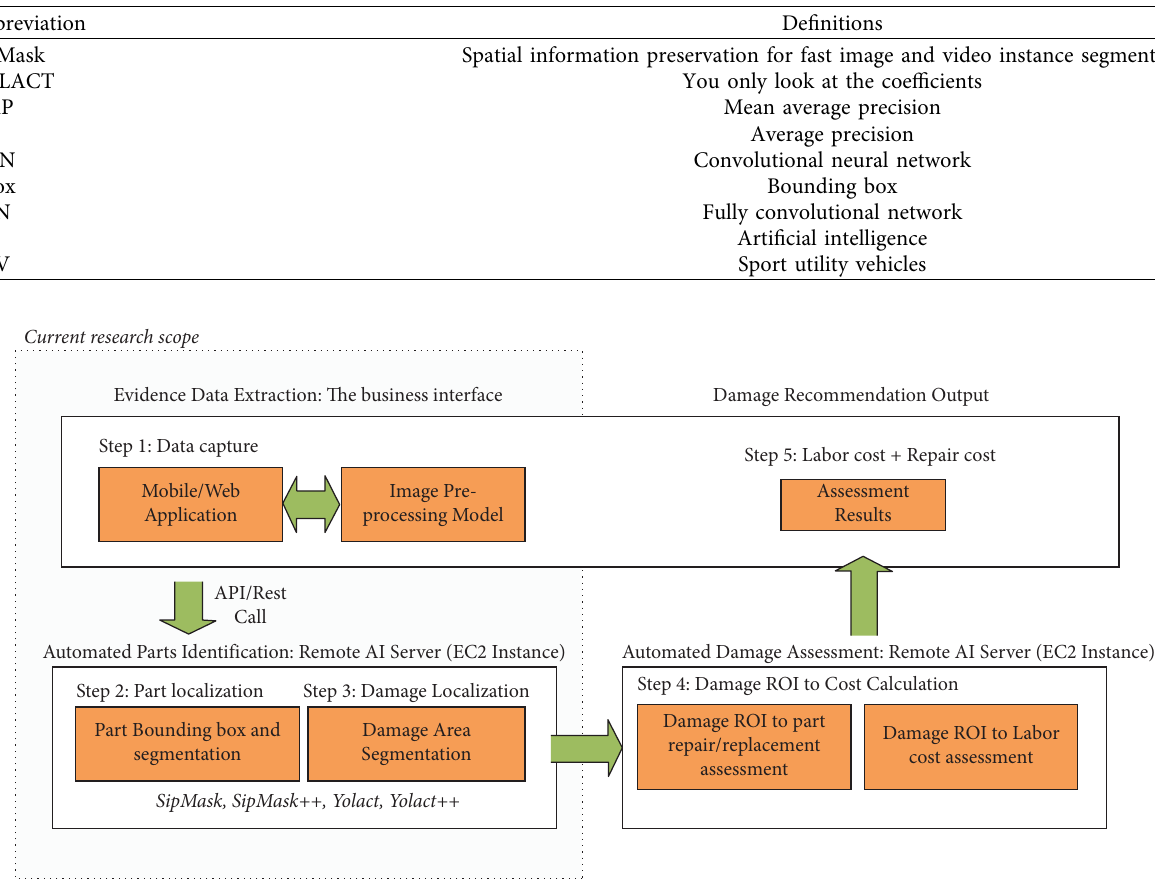
Table 1: Abbreviation